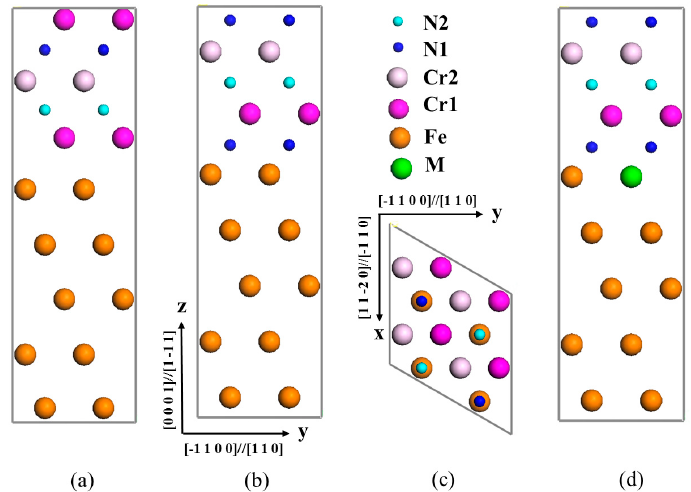
Figure 1. Side view of ( a ) Cr-terminated and ( b ) N-terminated γ -Fe(111)/Cr 2 N(0001) interface model. Top view of ( c ) interface configurations. Side view of ( d ) N-terminated γ -Fe(111)/ Cr 2 N(0001) after different solution atoms introduced (M = Mn, V, Ti, Mo, or Ni). (For interpretation of the references to color in this fi gure legend, the reader is referred to the web version of this article.)